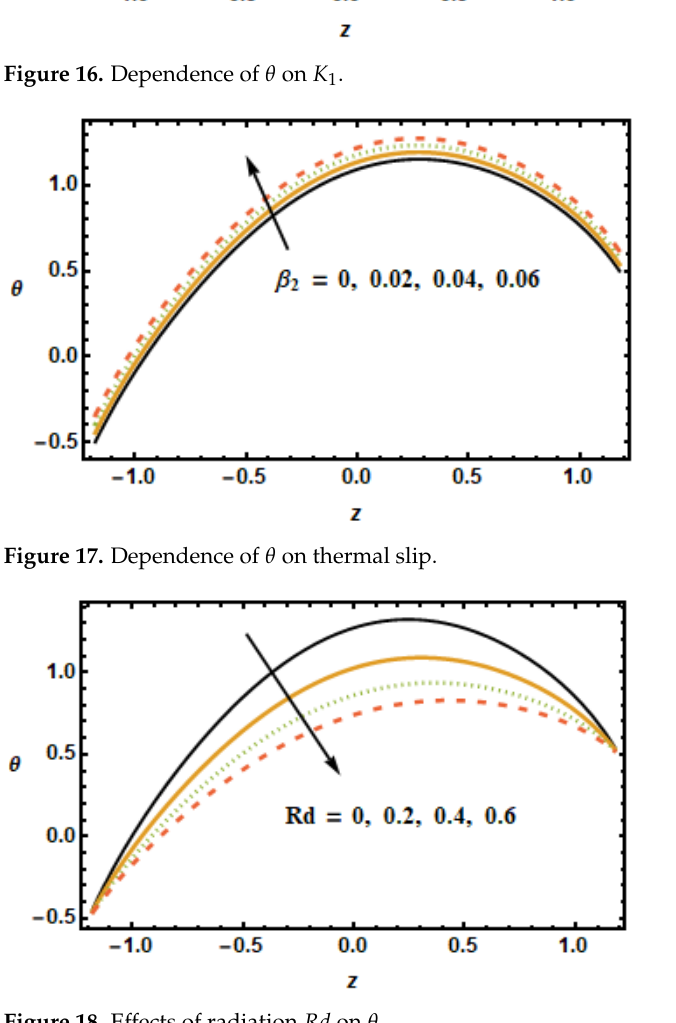
Figure 18. Effects of radiation Rd on